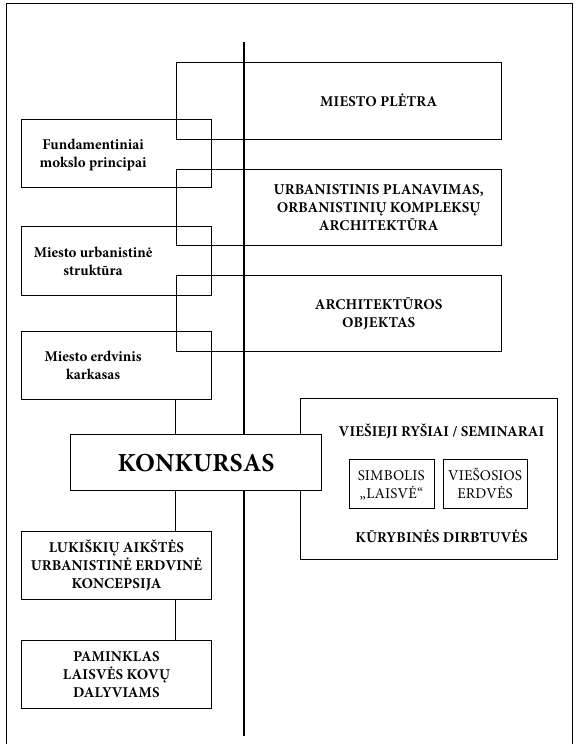
Fig. 5. Problem algorithm. Fundamental aspects of the problem, social and political order, professional practice, representation,